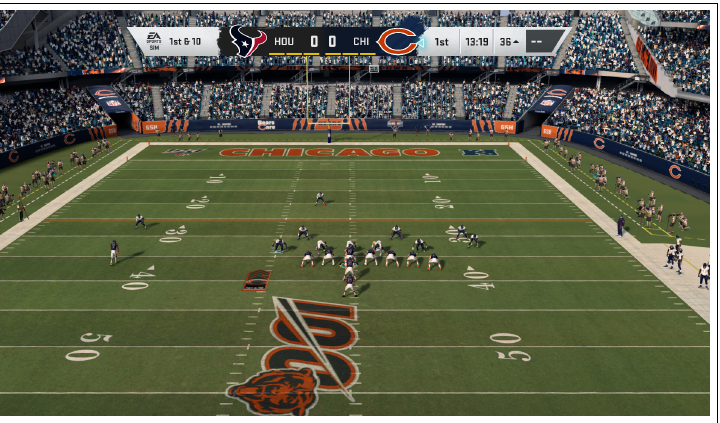
Figure 15. example of player occlusion—the center is directly in front of the quarterback, who is directly in front of two running backs. The player localization module has a difficult time locating all four of these players because of